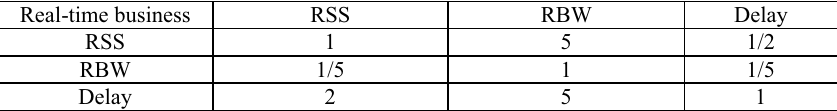
Table 2. Real-time business key variables pairwise comparison matrix.